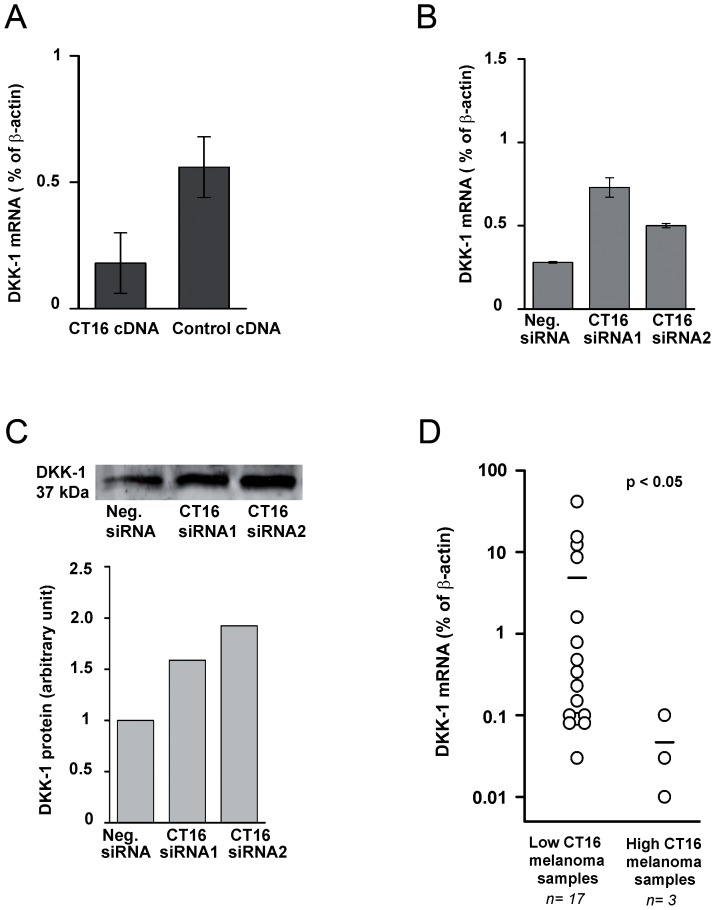
Regulation of DKK1 by CT16.(A) Verification of differential DKK1 mRNA expression in (WM-266-4 cells transfected with control cDNA or CT16 cDNA. by qRT-PCR. (B) Differential DKK1 mRNA expression was also repeatable in A2058 cells treated with indicated siRNAs for 48 h. (C) Western blot for DKK1 in culture medium of A2058 cells treated with indicated siRNAs for 48 h. (D) DKK1 is downregulated in melanoma samples with high CT16 expression. CT16 and DKK1 mRNA levels of melanoma skin metastasis tissue samples were detected by qRT-PCR. The p value was obtained by testing the difference in DKK1 mRNA level between the melanoma samples with high CT16 mRNA level (>22% of β-actin mRNA) and those with low CT16 mRNA level (<7% of β-actin mRNA) by Tukey-Kramer test.